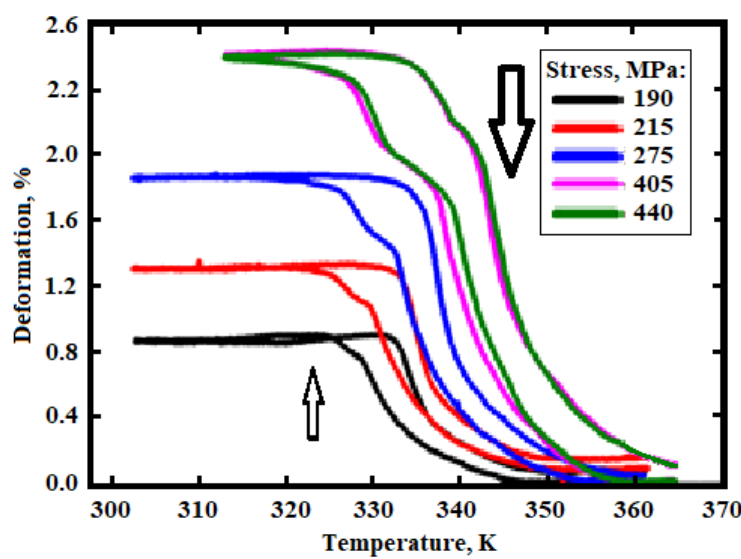
Figure 2. Temperature dependences of sample deformation at various constant mechanical loads (indicated in the inset of the graph, MPa) for an annealed strip (up arrow — direct transformation upon cooling, down arrow — reverse transformation upon heating).